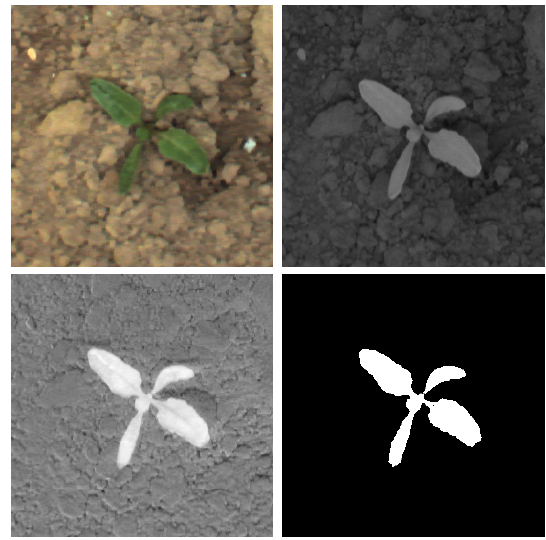
Figure 2. Top: RGB and NIR images. Bottom: NDVI transform and mask obtained by a conservative threshold in the NDVI